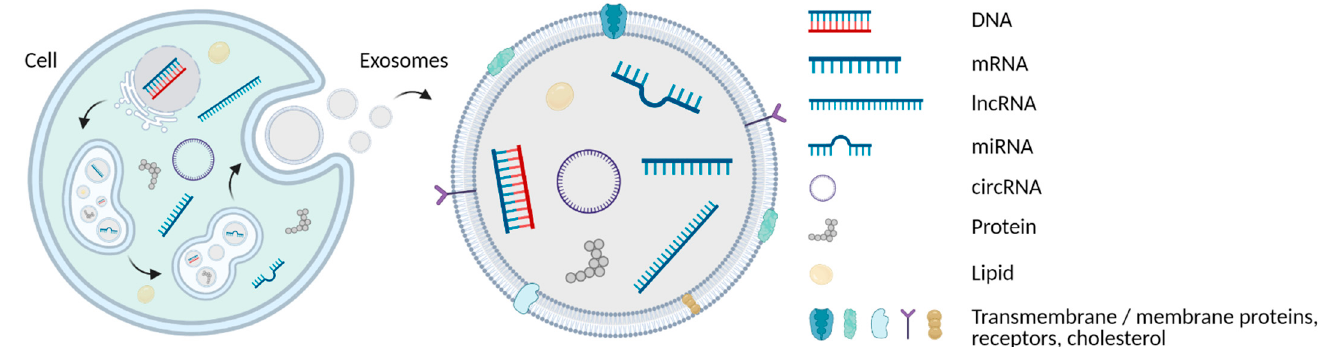
Figure 2. Formation of exosomes. Schematic illustration of the genesis and content of multivesicular bodies (MVB) formed from the endoplasmic reticulum (ER) and producing exosomes. They may be loaded with various cargo, such as cfDNA of nuclear and mitochondrial origin, multiple types of cfRNA, proteins and lipids, found both on the inside and on the surface of exosomes. Their phospholipid bilayer contains additional components: proteins, membrane receptors, etc. (Created with BioRender.com).